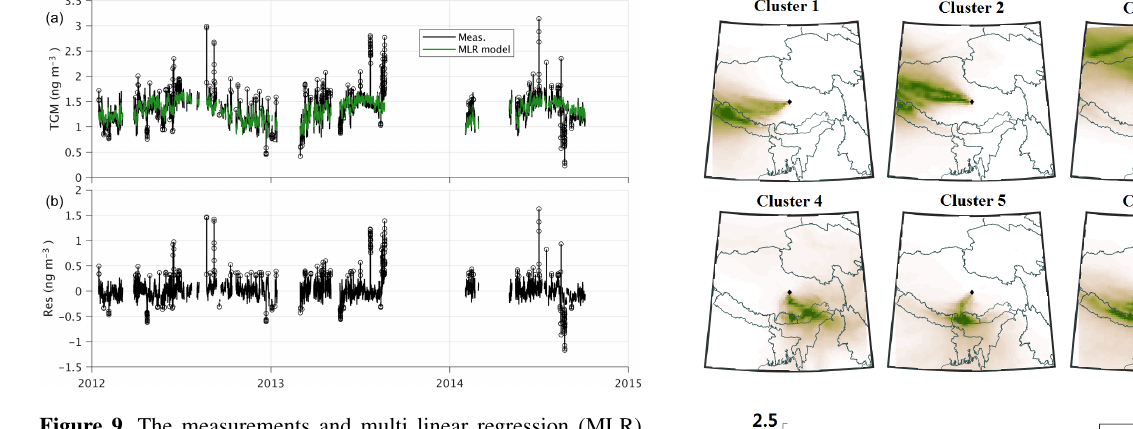
Figure 9. The measurements and multi linear regression (MLR) model of TGM (top) and model residual (bottom) (resid- ual = measurement − simulation). The outliers are shown as circles.